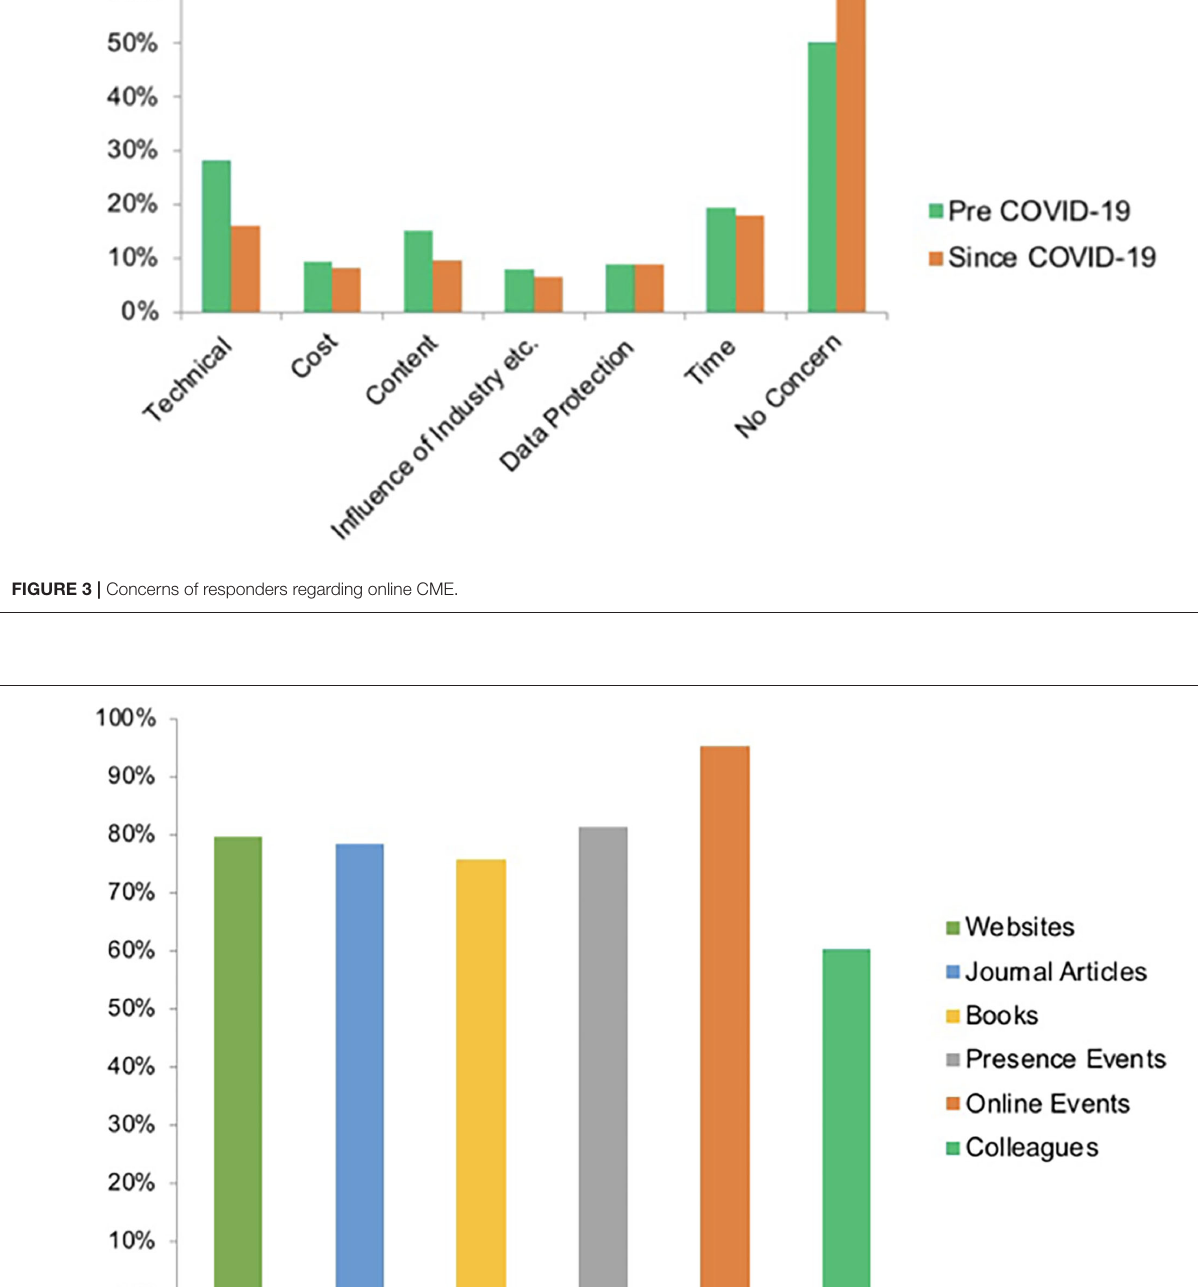
Frontiers in Medicine |